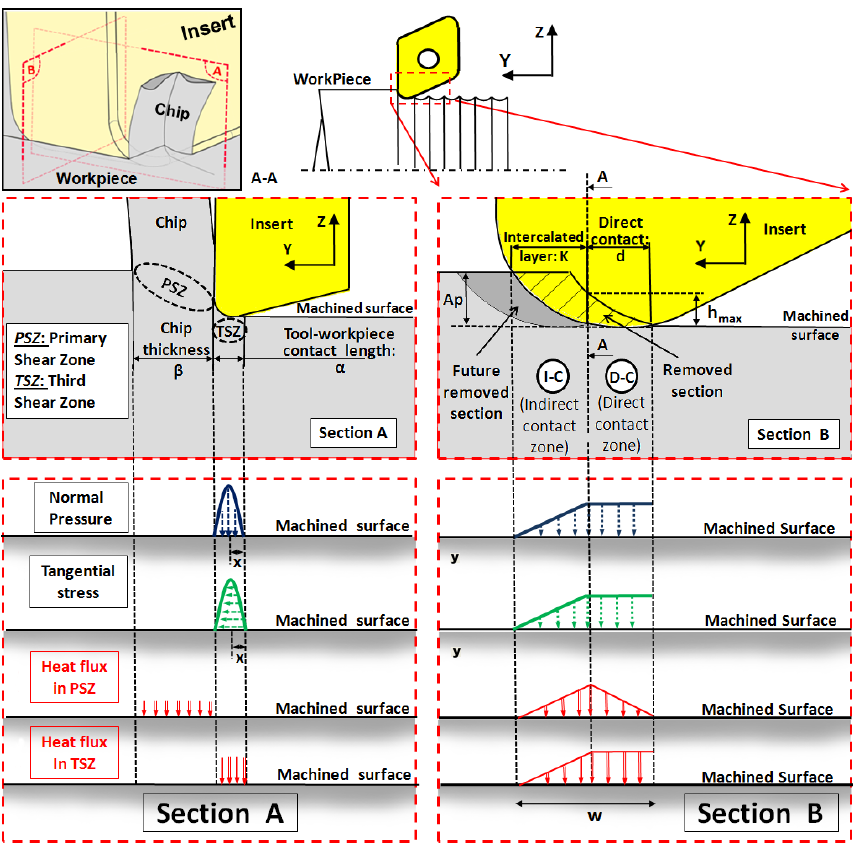
Figure 5. Modelling of the equivalent thermal and mechanical loadings on the machined surface [23].